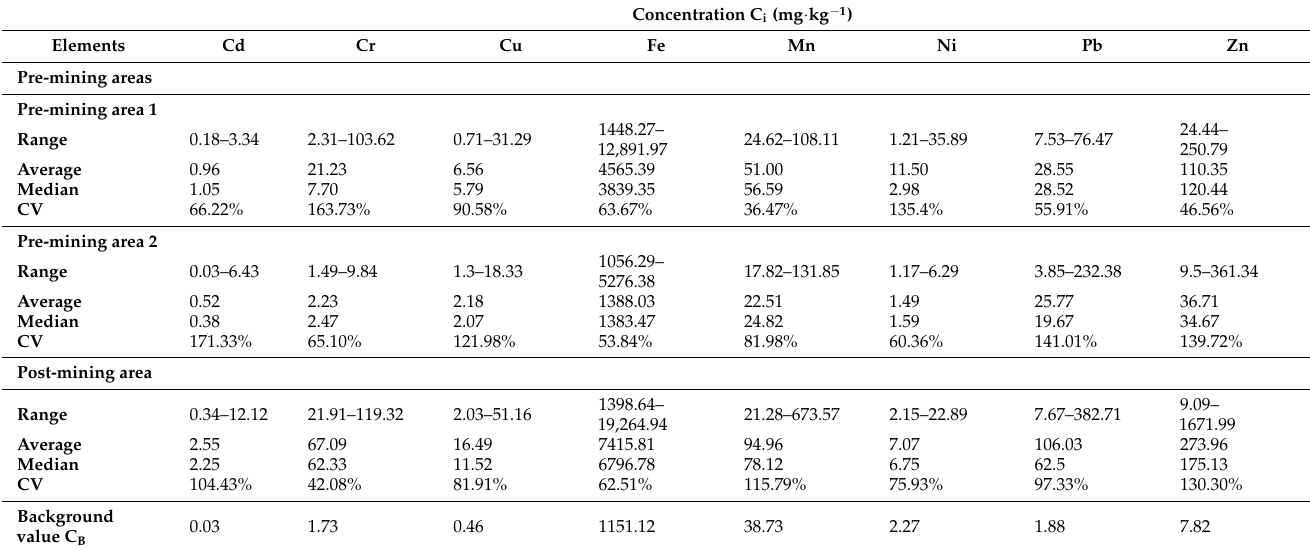
Table 3. Statistics of heavy metals concentration in soil